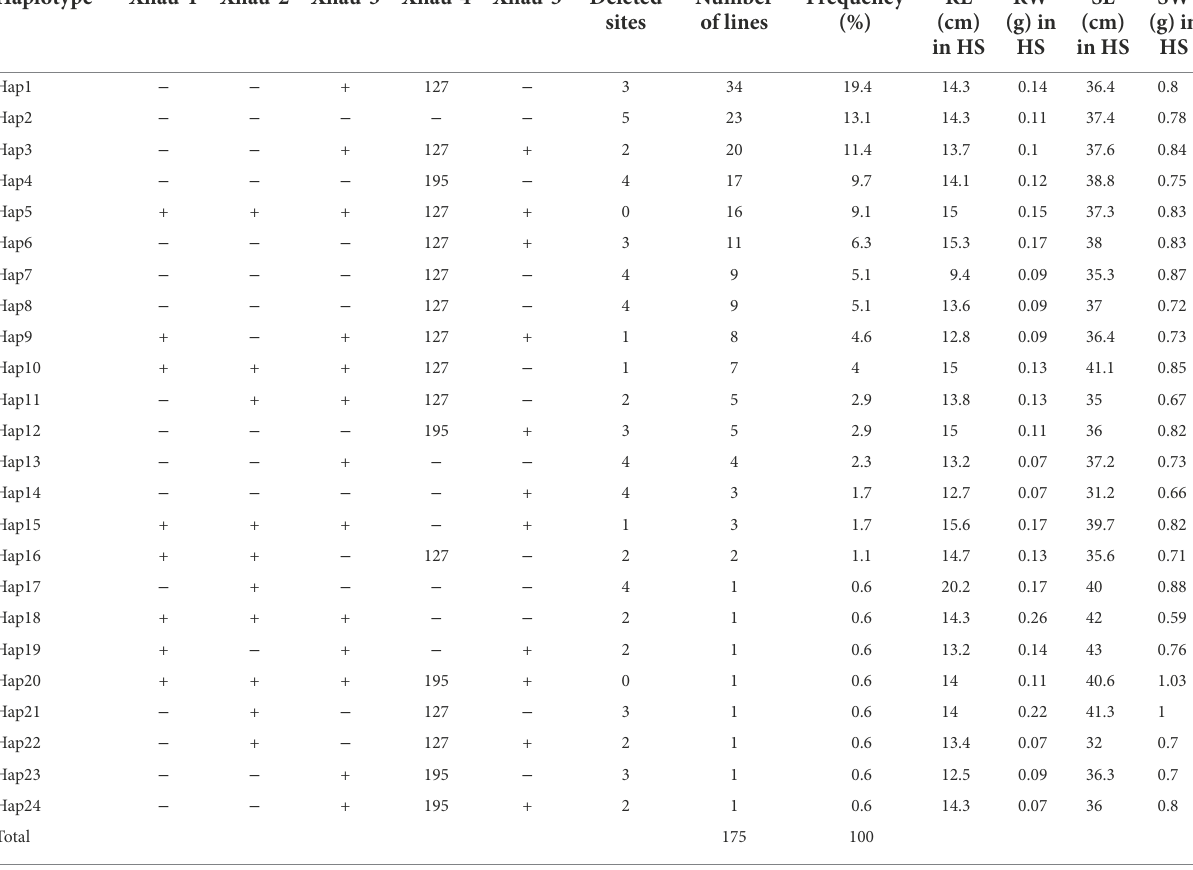
TABLE 4 Description of 24 haplotypes for TaHST1 QTL.